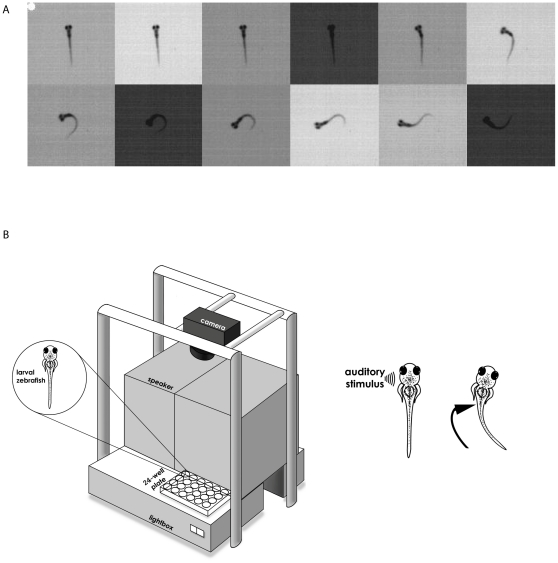
The C-start reflex in larval zebrafish and the experimental apparatus used to study habituation of the reflex.(A) Representative C-start reflex in a zebrafish larva. Frames commence at the presentation of an auditory/vibrational (AV) pulse; the white dot indicates the initiation of the C-start reflex. Images were recorded at 1000 frames/s. For illustration purposes, only every other frame is shown. (B) Experimental apparatus used to elicit the C-start. The plastic wells containing the zebrafish were placed on top of a light box, which was used to achieve adequate visual contrast during video recording. Each well was filled with ∼3 ml of E3 and contained one zebrafish. We were able to record the responses of as many as 24 zebrafish in a single session.